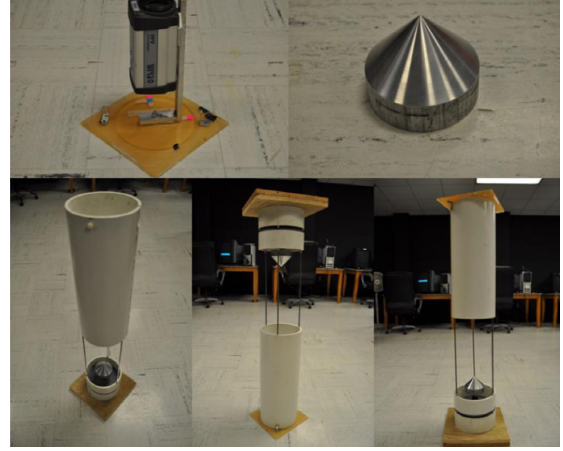
Figure 19. 360 ◦ profiling sensor prototype designed and built at the University of Memphis